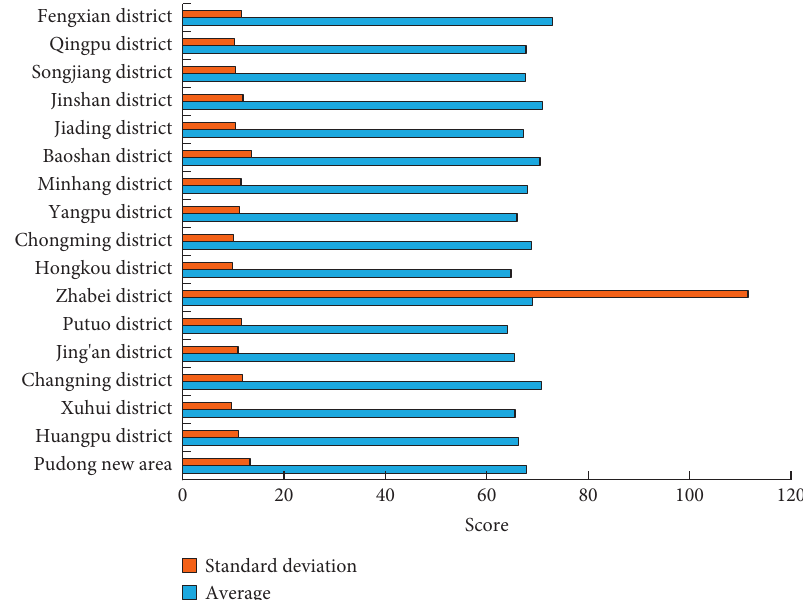
Figure 6: Social service satisfaction score of all districts and counties in A province.